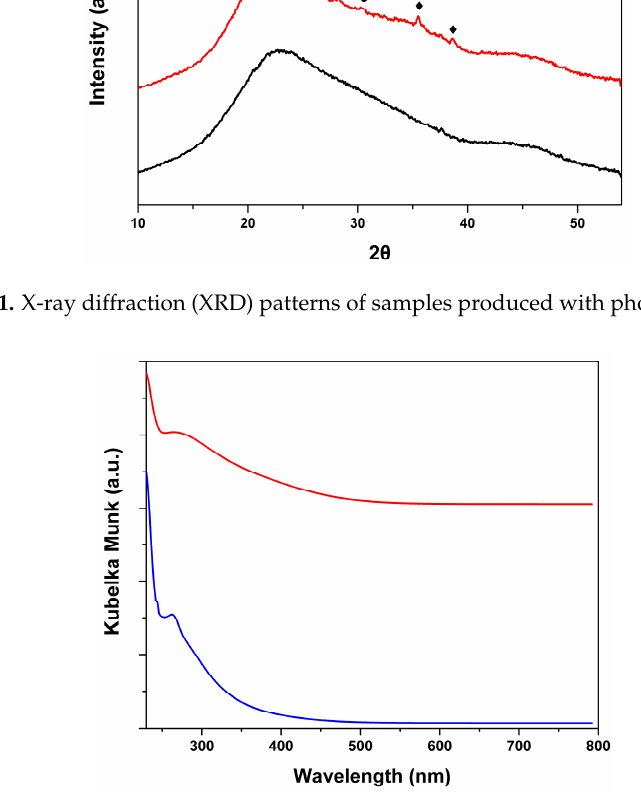
Figure 1. X ‐ ray diffraction (XRD) patterns of samples produced with phosphate buffer.